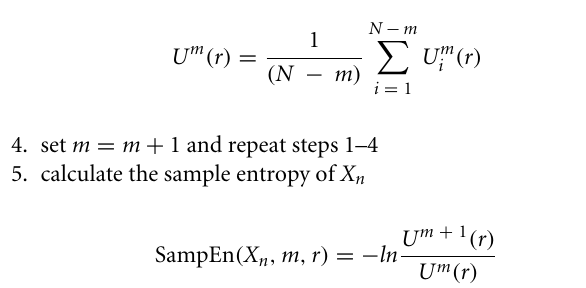
context. In the present study, we extracted expressive features of violinists playing in a solo and in a string quartet, respectively. Violinists’ head movements were obtained by the Qualisys motion capture system, and we analyzed the regularity of head movements using a measure of entropy